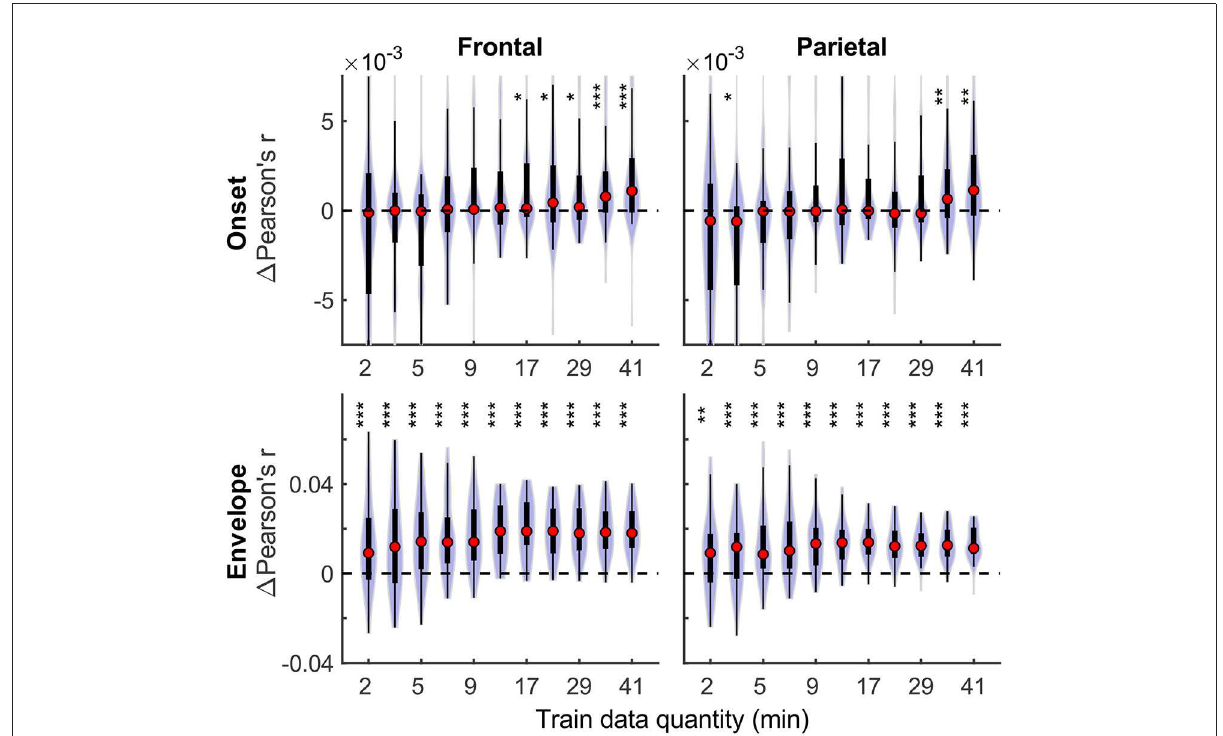
FIGURE2 Feature-specific model fit contributions as a function of training data quantity for the denser model. Model fit contributions reflect the unique contribution of each feature to the overall prediction accuracy of the full model, compared to reduced models in which those features were excluded. Note the different scales of the contributions for the Onset (Upper row) and Envelope (Lower row) features, with the latter fit contributions being about an order of magnitude larger than the former. To facilitate visualization of the central portion of the distributions, upper and lower limits of some of the violin plots for the “Onset” feature are truncated. Asterisks denote significance levels as in Figure